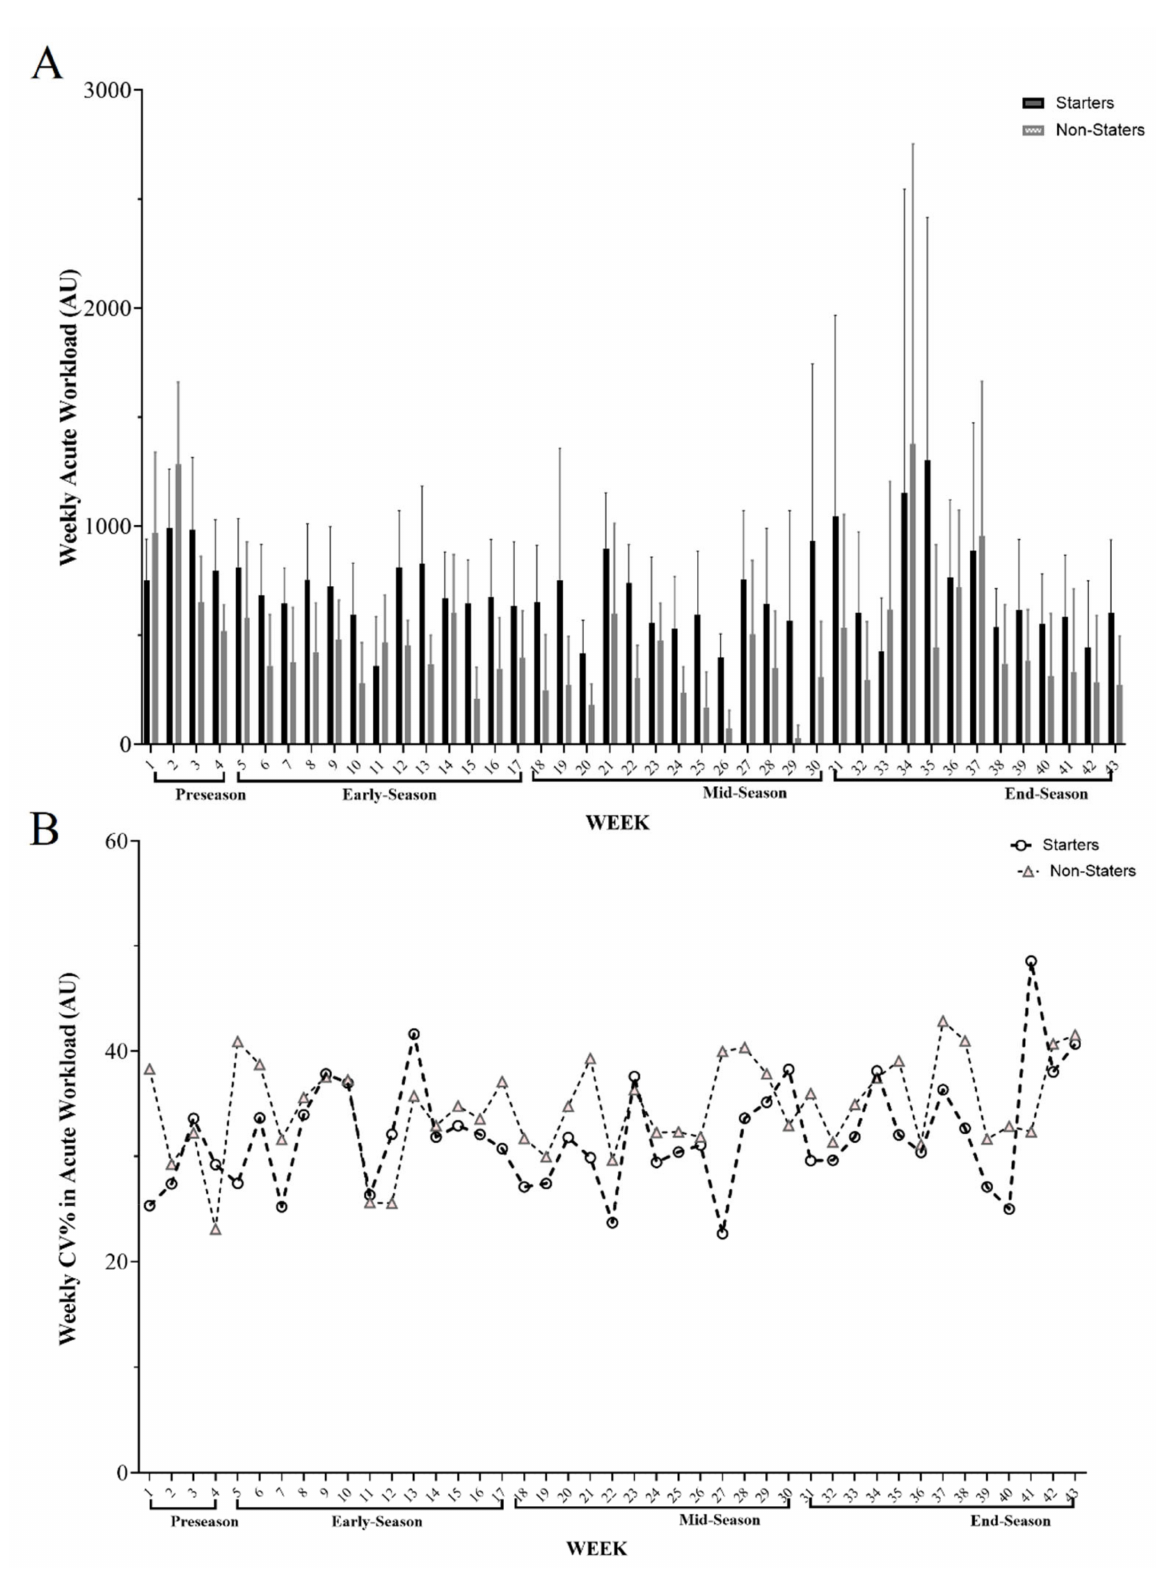
Figure 1. ( A ) Descriptive variations across AW (weekly acute workload) during the full season based on periods and ( B ) between weekly coefficient of variation (%CV) for this variable based on